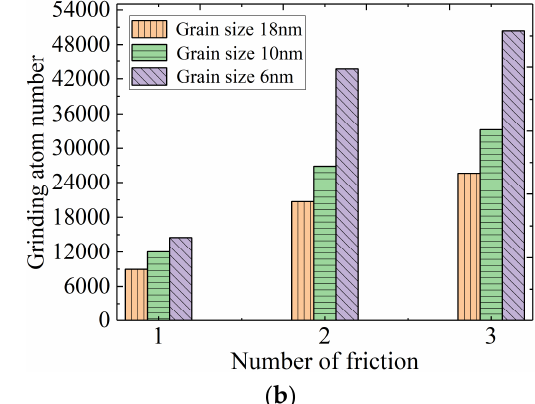
( b ) Figure 16. Frictional force and friction coefficient with different grain sizes, ( a ) is the frictional force diagram and ( b ) is the friction coefficient diagram.